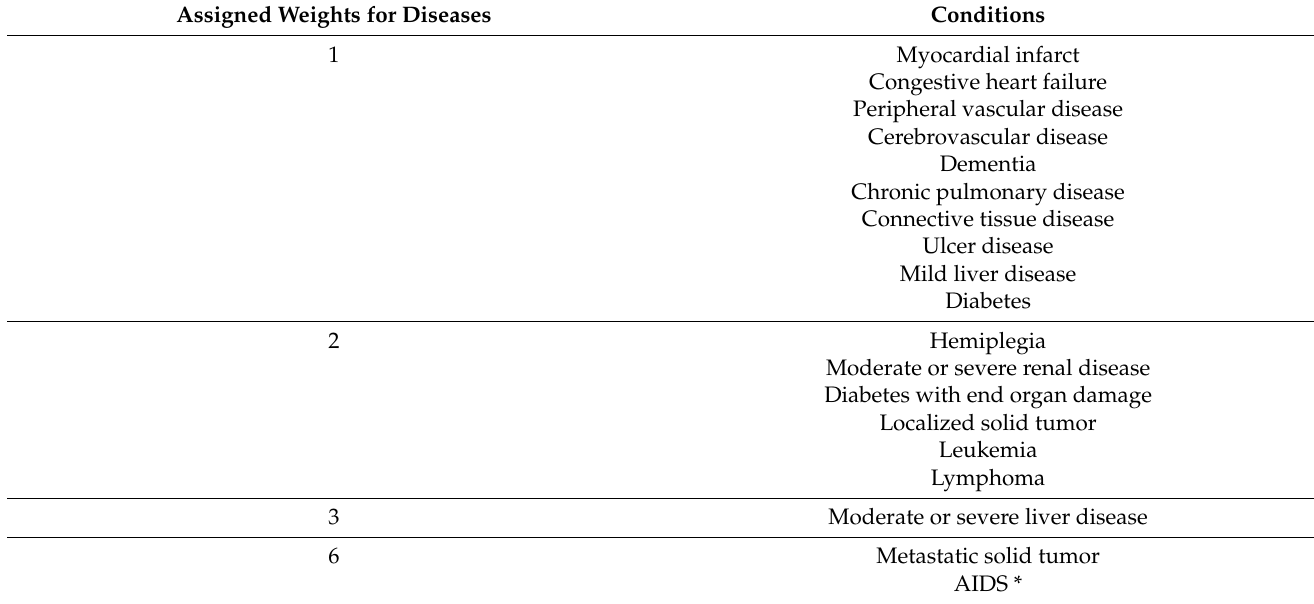
Table A1. Weighted index of comorbidity as described by Charlson et al. [38]. Assigned Weights for